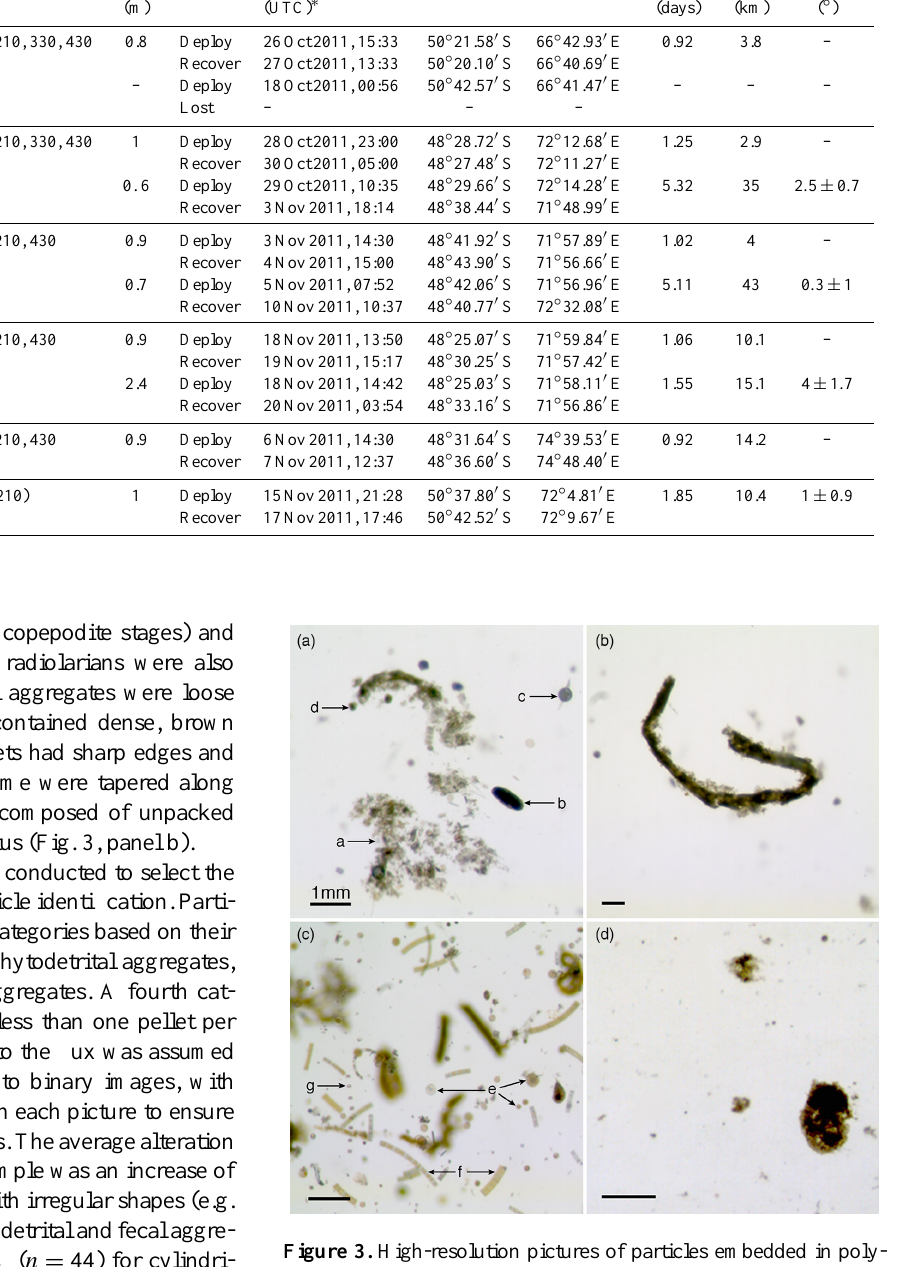
Figure 3. High-resolution pictures of particles embedded in poly- acrylamide gels showing the main categories of particles collected. Panel (a) – a: Phytodetrital aggregate; b: oval fecal pellet; b: ra- diolarian, d: foraminifera; panel (b) large cylindrical fecal pellet; panel (c) – e: small and large centric diatom single cells; f: chains of pennate diatoms of the genera Fragilariopsis spp., g: chain of small centric diatom cells; panel (d) fecal aggregate. Note the dif- ference in compactness and optical density between phytodetrital and fecal